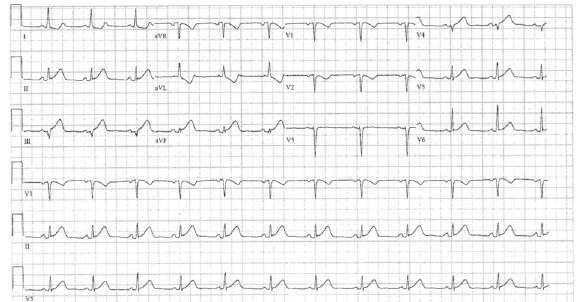
Figure 1: The initial ECG at presentation with active chest pain.